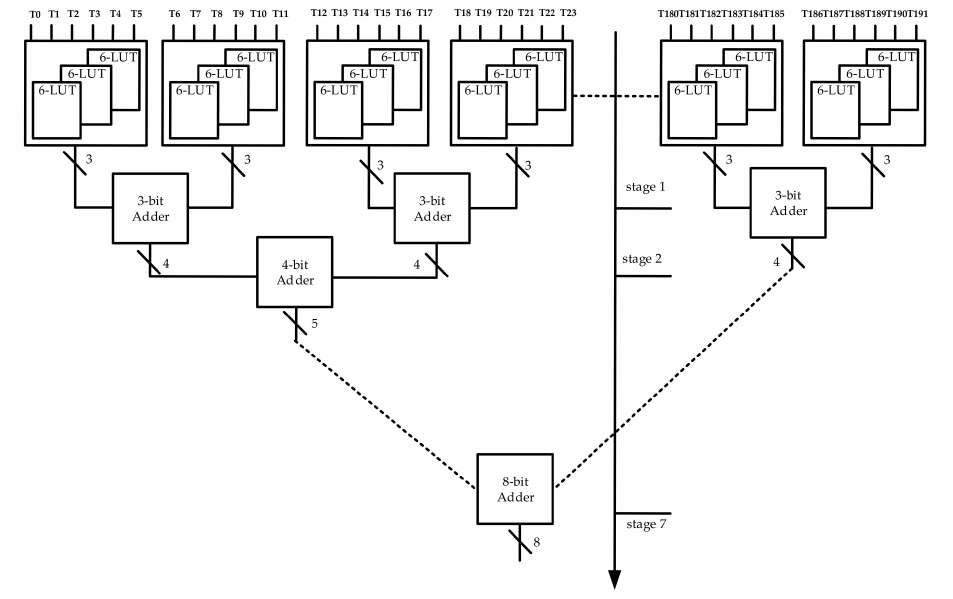
Figure 4. The proposed ones-counter